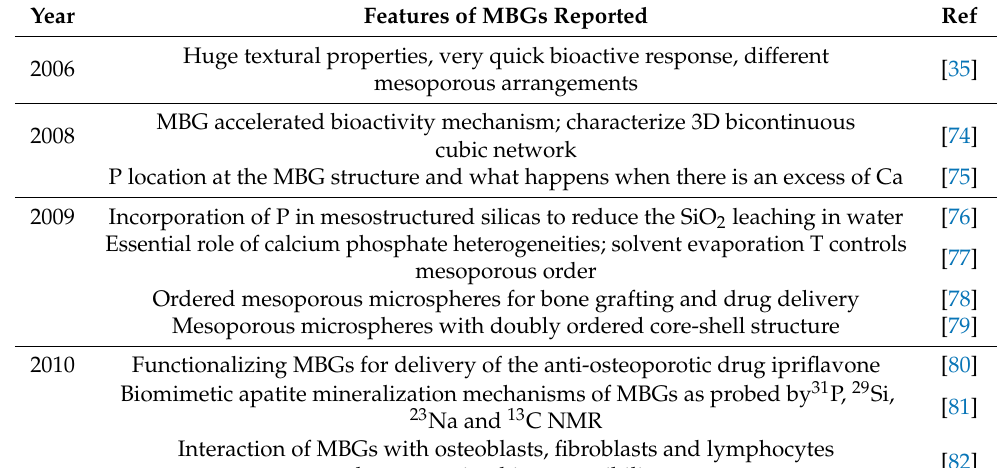
Table 1. Papers of Vallet-Reg í from 2006 to 2021 including significant advances in